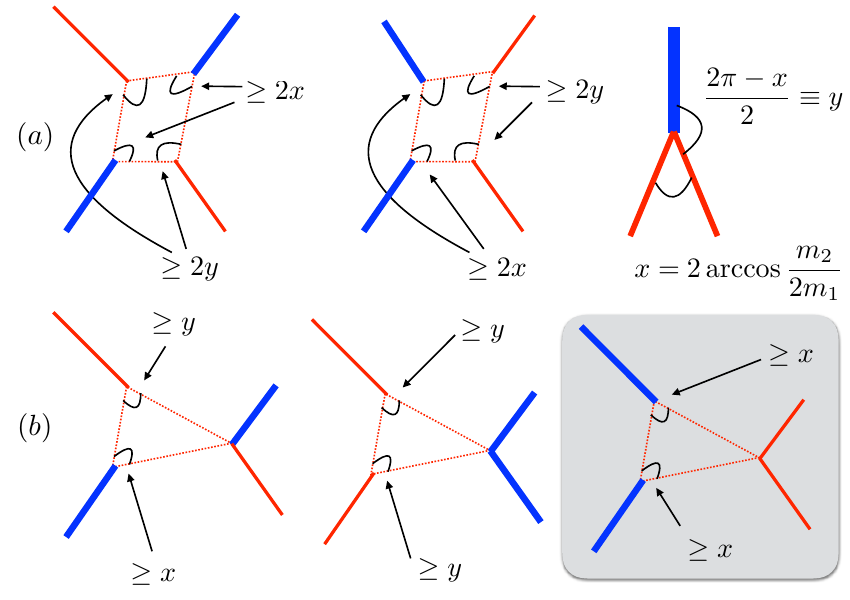
Figure 29. (a) There are no possible \quadrilateral convex hull" Landau singularities in the 12 12 amplitude even when m 2 > p 2 m 1 . To understand this, consider a vertex with an external ! leg attached. The total opening between internal edges on such vertex must be greater than x ( y ) for an external even (odd) leg. Hence, for the 12 12 process, the total internal angles at ! the four external vertices must be greater than 2( x + y ) 2 (cid:25) , so that it is inconsistent to have a (cid:21) closed singular diagram inside the convex hull. (b) The same is true for \triangular convex hull" diagrams unless two odd particles meet at the same external vertex, as on the bottom right diagram - as in other cases the total opening at external vertices would be greater than (cid:25) . For the